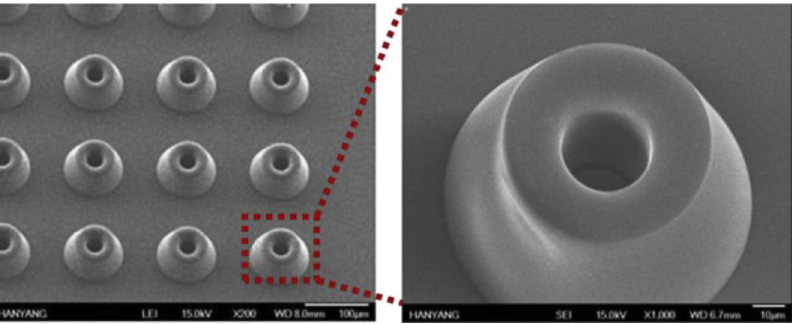
Figure 17. SEM micrographs of the micro needle surfaces of PLA/MWCNTs nanocomposites [232].